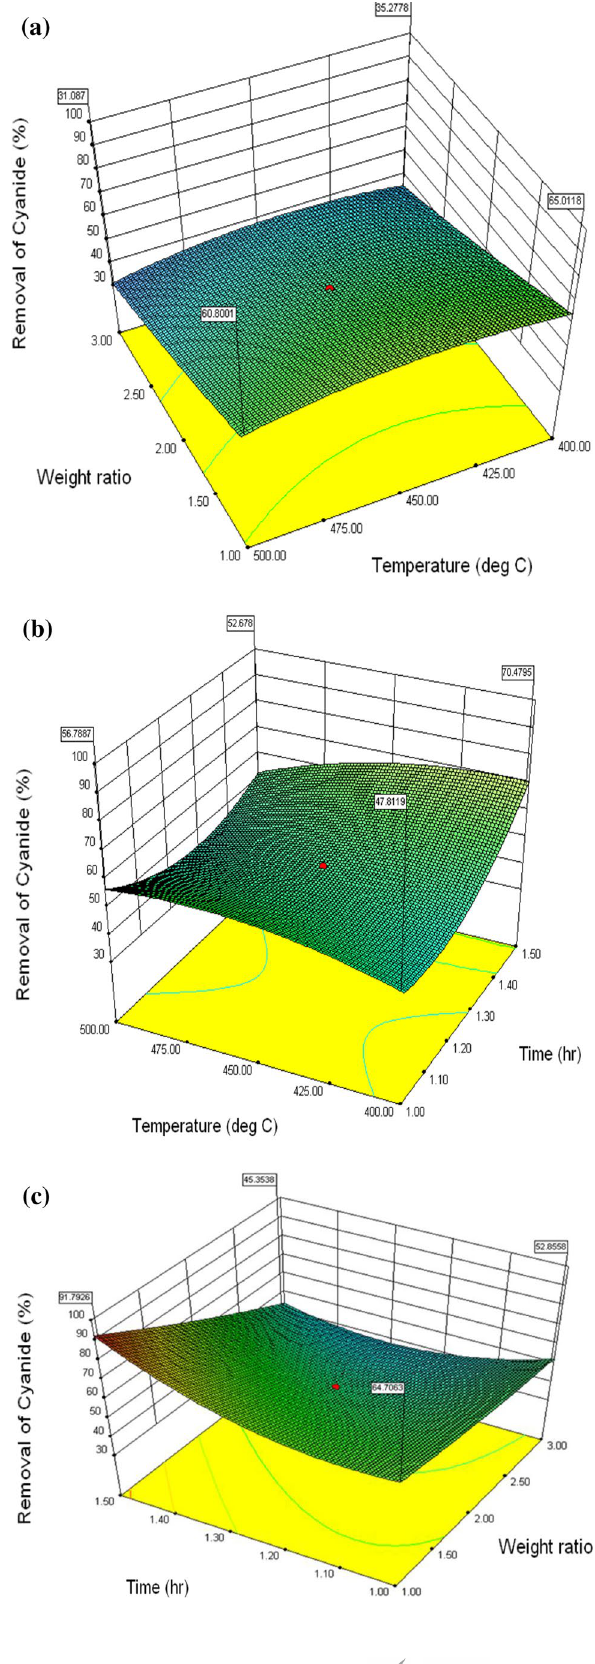
Fig. 1 Conjugate effect a weight ratio and temperature, b tempera- ture and carbonization time, c weight ratio and carbonization time on removal of cyanide